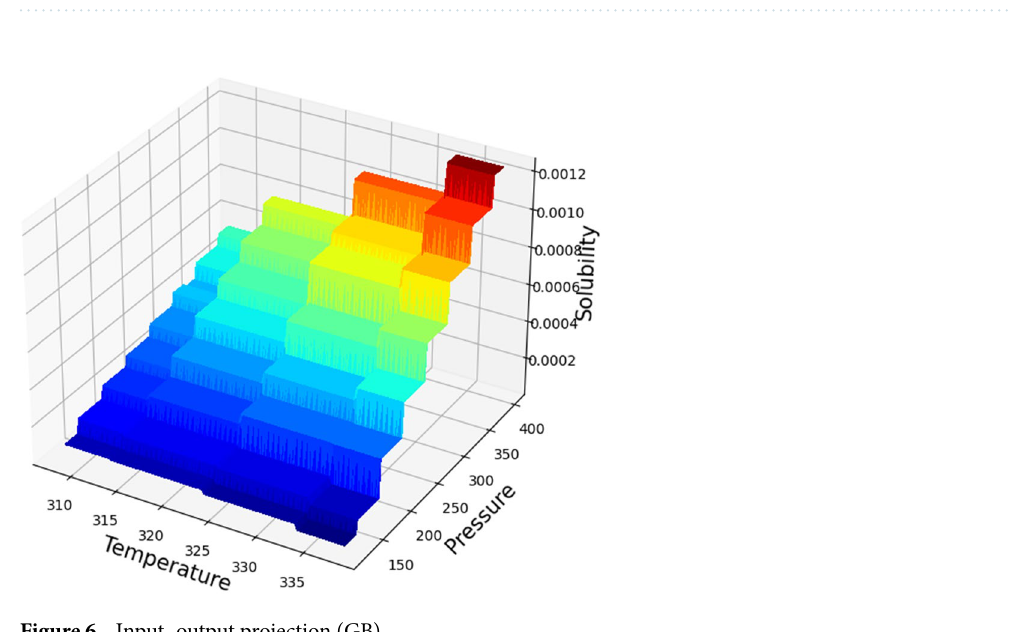
Table 2. Final model results.